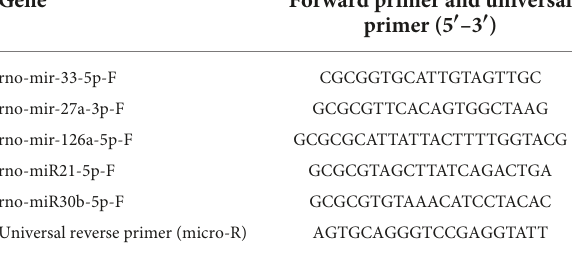
TABLE 3 Real-time PCR primers of